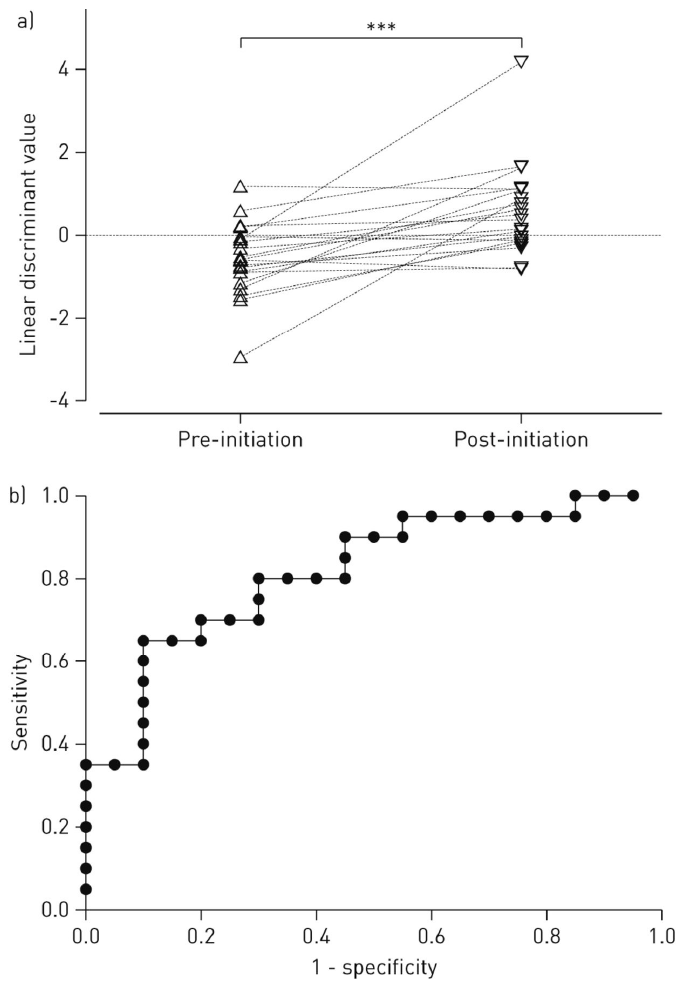
Figure 14. ( a ) The (paired) values of the linear discriminant analysis of sleep apnoea patients before (pre-initiation) and three months after (post-initiation) initiation of continuous positive airway pressure therapy differ statistical significantly. ( b ) The area under the receiver operating characteristic curve equals 0.82, resulting in a sensitivity of 0.80 and a specificity of 0.65. ***: p < 0.001, Wilcoxon signed-rank test. Used with permission from [92].